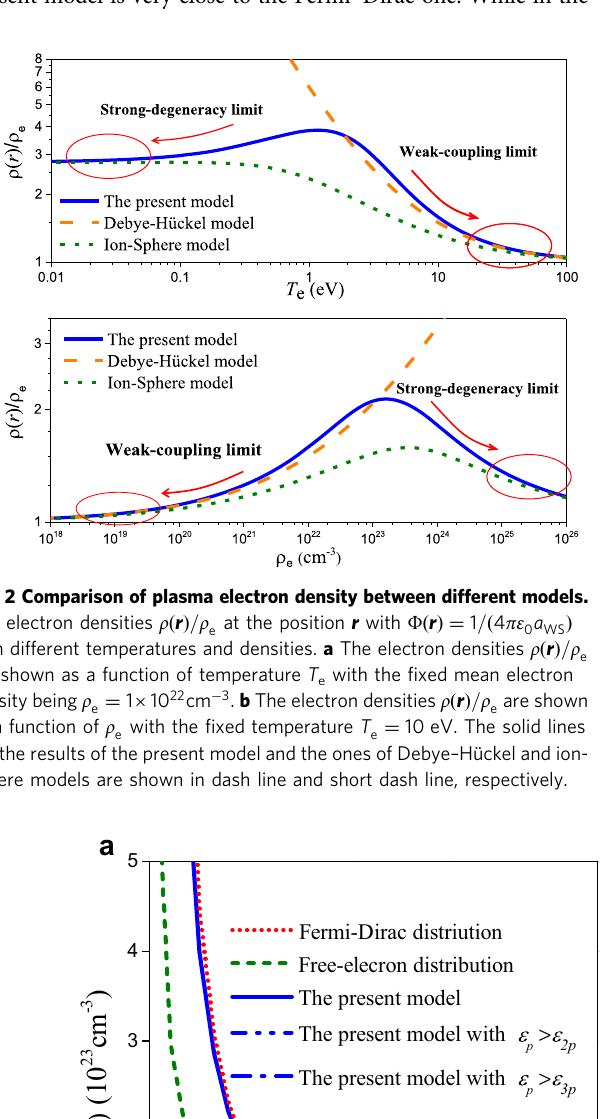
is 3 ´ 10 23 cm (cid:2) 3 , the temperature e ε ε and ε are shown in p > 2 p p > 3 p